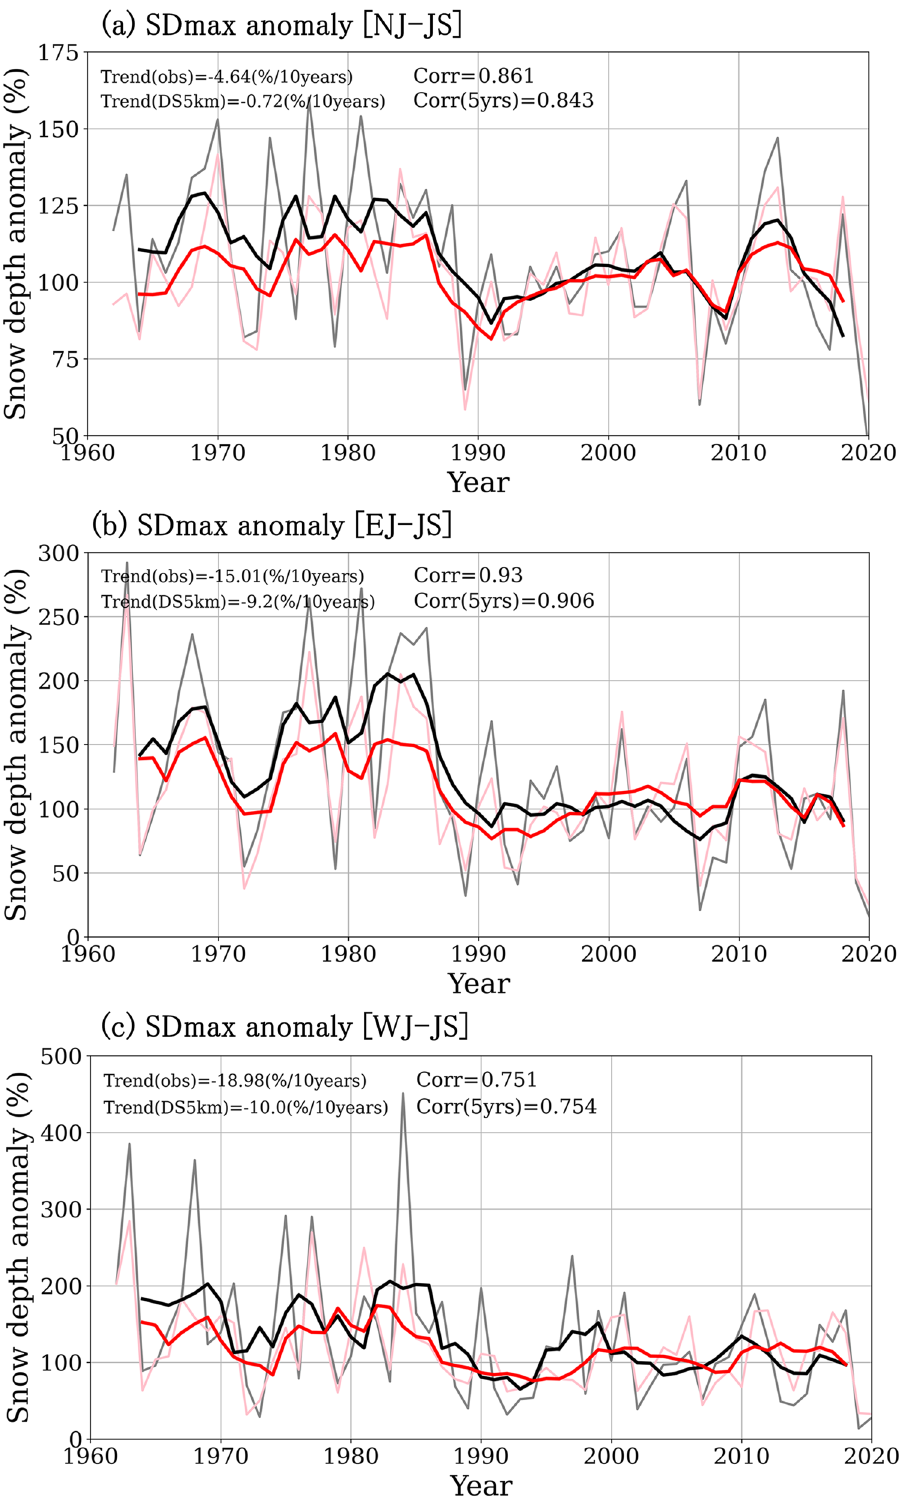
Fig. 5 Time series of SDmax anomalies over the Japan Sea coast from 1962 to 2020. a Northern Japan, b eastern Japan, and c western Japan. The reference climate is 1991–2020. Thick and thin lines represent the annual and 5‑year means, respectively. Black and red lines represent the observation and DS5km,